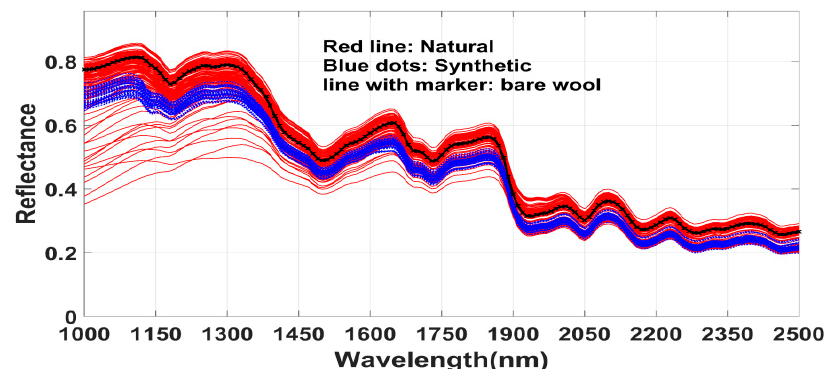
Figure 7. Reflectance spectra of bare wool and fibers dyed with natural Madder and synthetic red dyes.